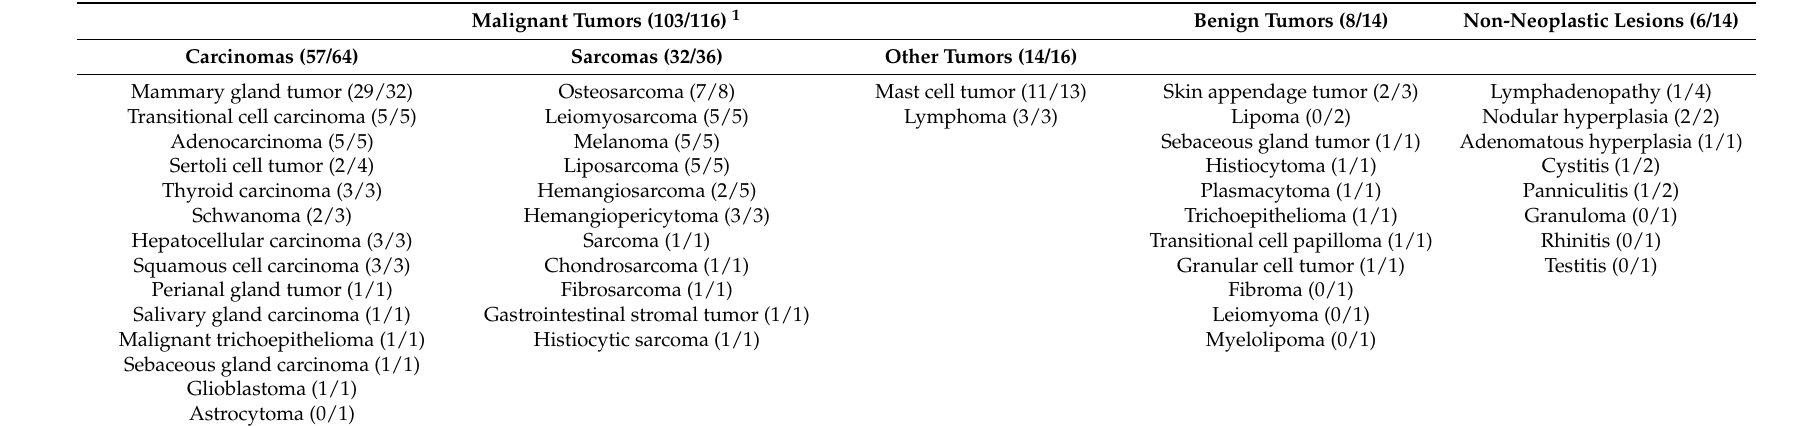
1 Numbers in parentheses: Number of positive subjects/number of positive and negative